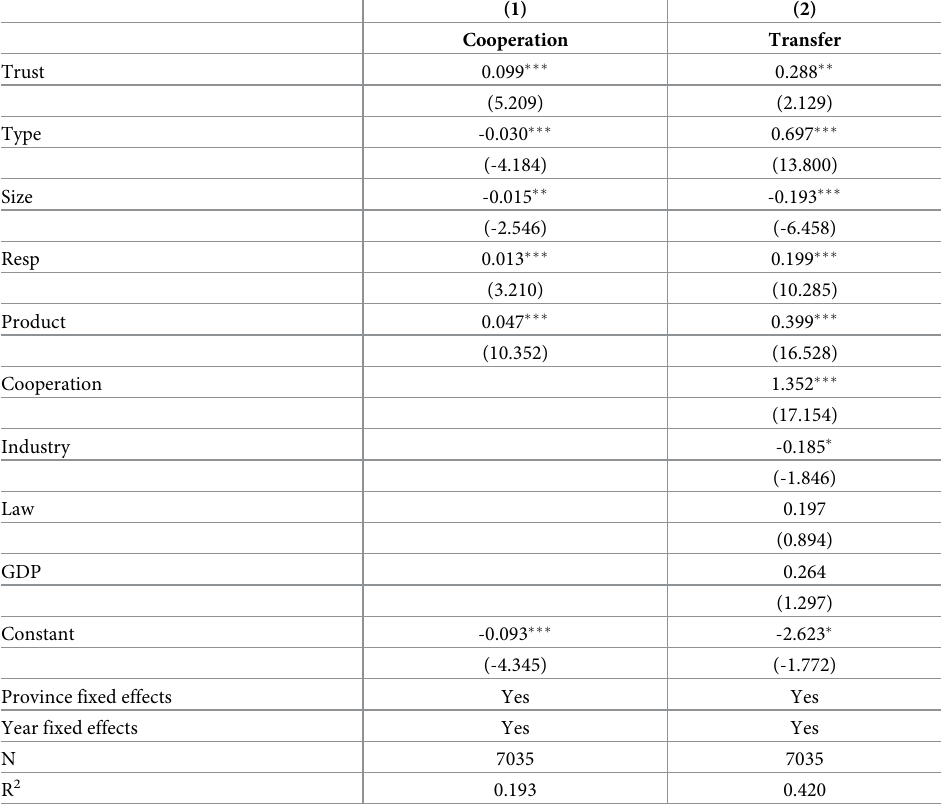
Table 5. Mechanism